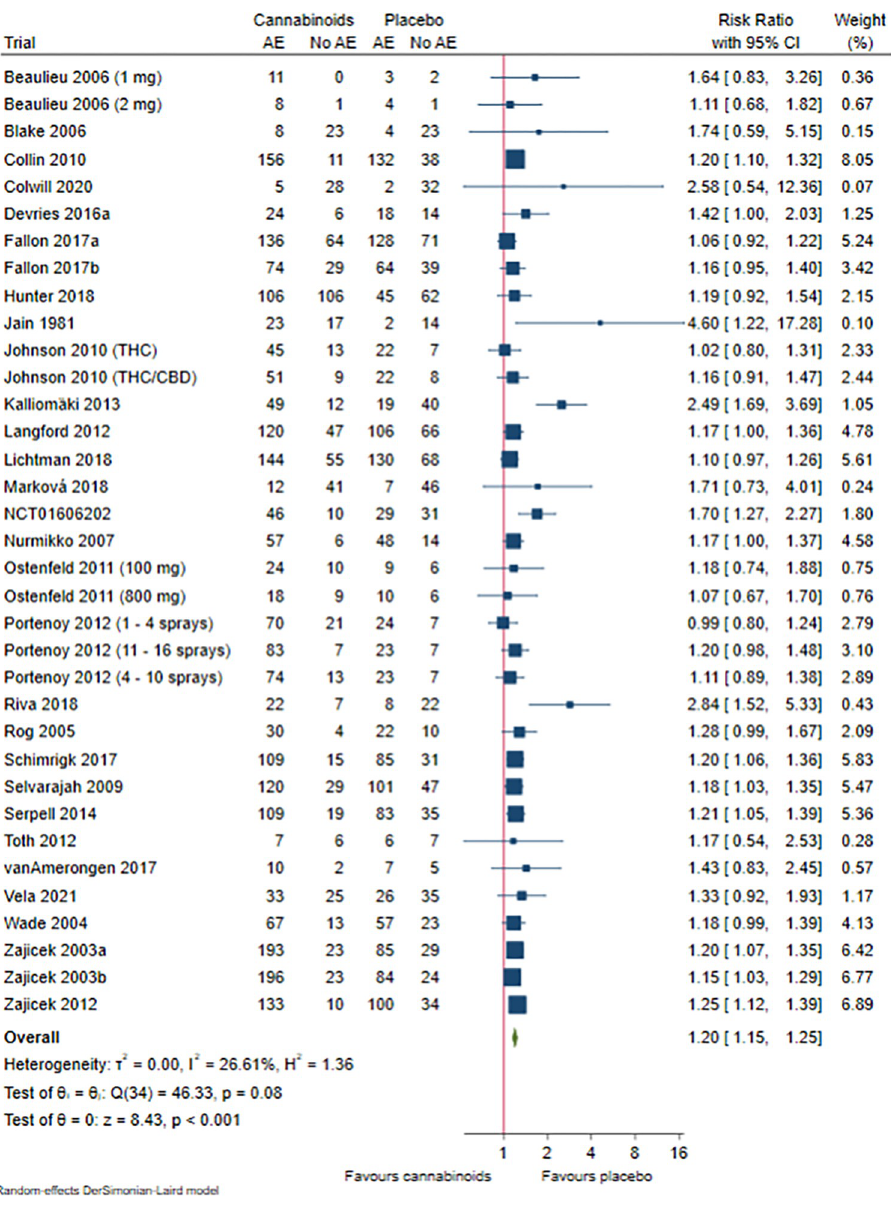
Fig 4. Forest plot of the meta-analysis of non-serious adverse events with 95%